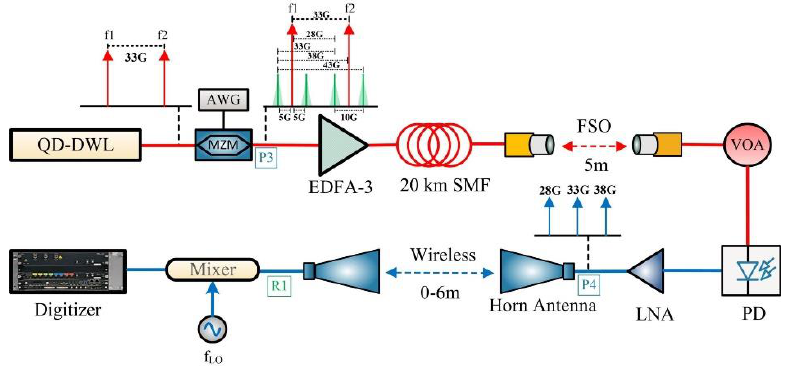
Figure 3. MMW transmission setup showing a hybrid single-mode fiber (SMF), free space optics (FSO), and wireless (WL) channel (20-km SMF, 5-m FSO, and 0–6 m WL link). The left inset shows the dual-wavelength modes of the QD-DWL, while the right inset illustrates the possible beating of